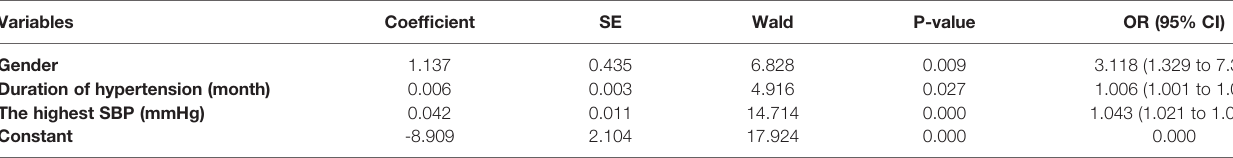
CI, con fi dence